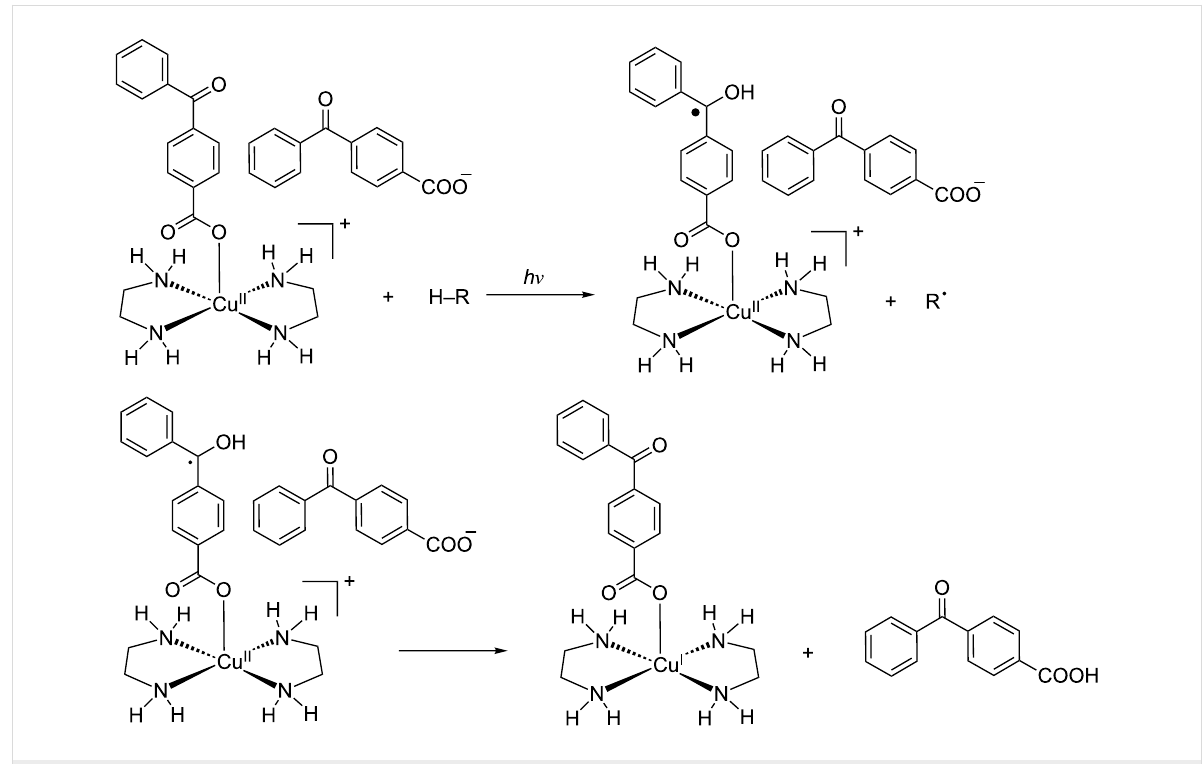
Scheme 3: Proposed mechanism for the photoreduction